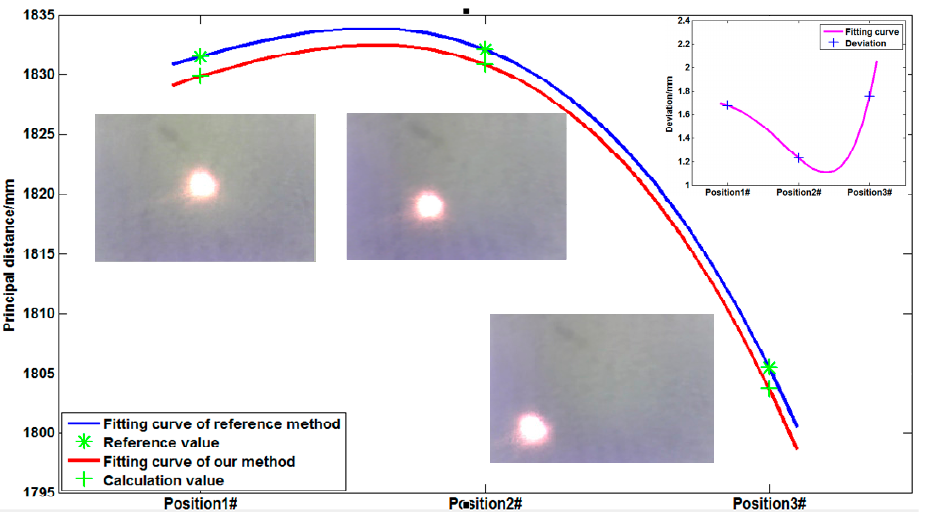
Figure 13. Calibrated results of the three specific positions.